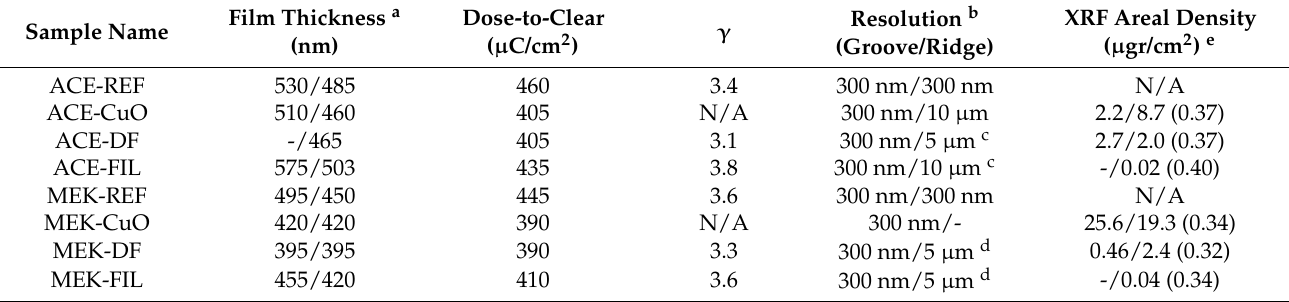
Table 4. Summary of Phase 2